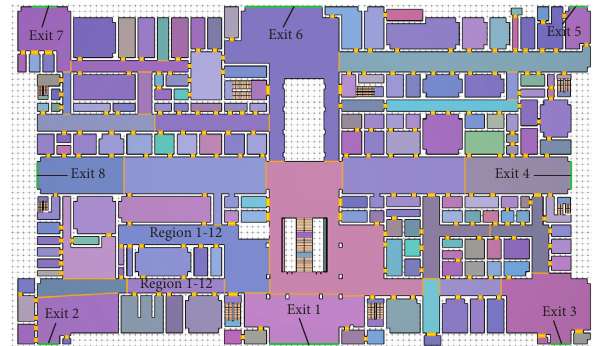
Figure 35: Region 1–12 in pathfinder.